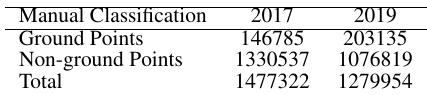
Table 2. Number of manually classified ground and non-ground points in the vegetated test area without the